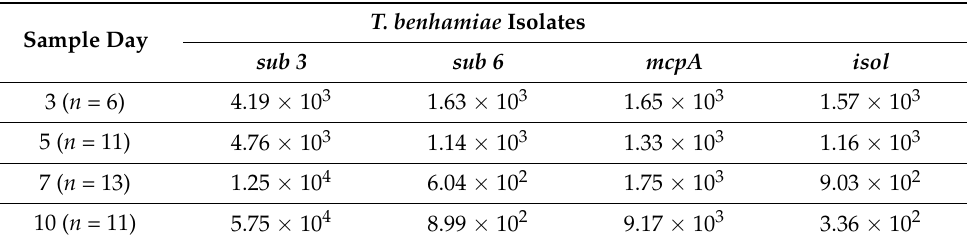
Table 3. Median expression rates of the virulence factors sub 3 , sub 6 , mcpA and isol of T. benhamiae isolates in GPSE culture from d 3 to d 10 (normalized to 10 3 ADPrf